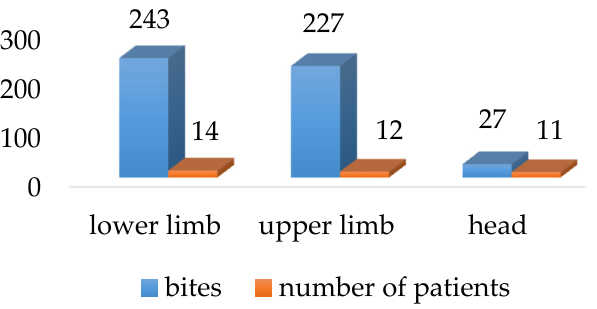
Figure 2. Location of black fly bites on exposed parts of the body in patients with severe local reactions ( n = 37).